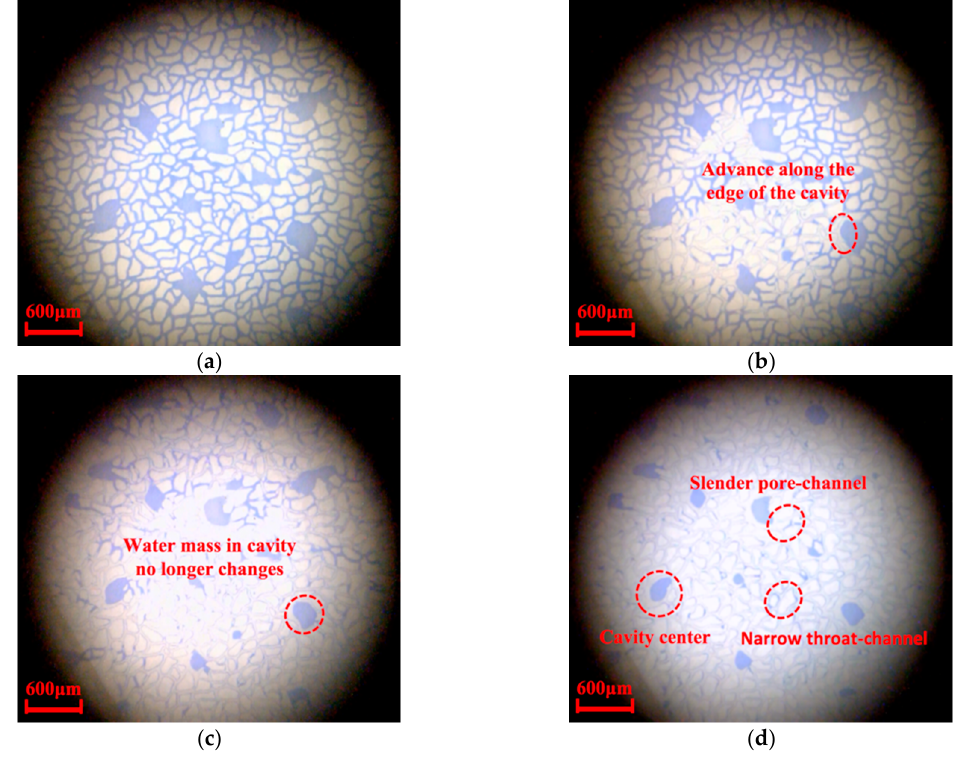
Figure 11. Gas-drive-water process of the cavity-type micromodel: ( a ) Initial stage; ( b ) Second stage; ( c ) Third stage; ( d ) Final stage.